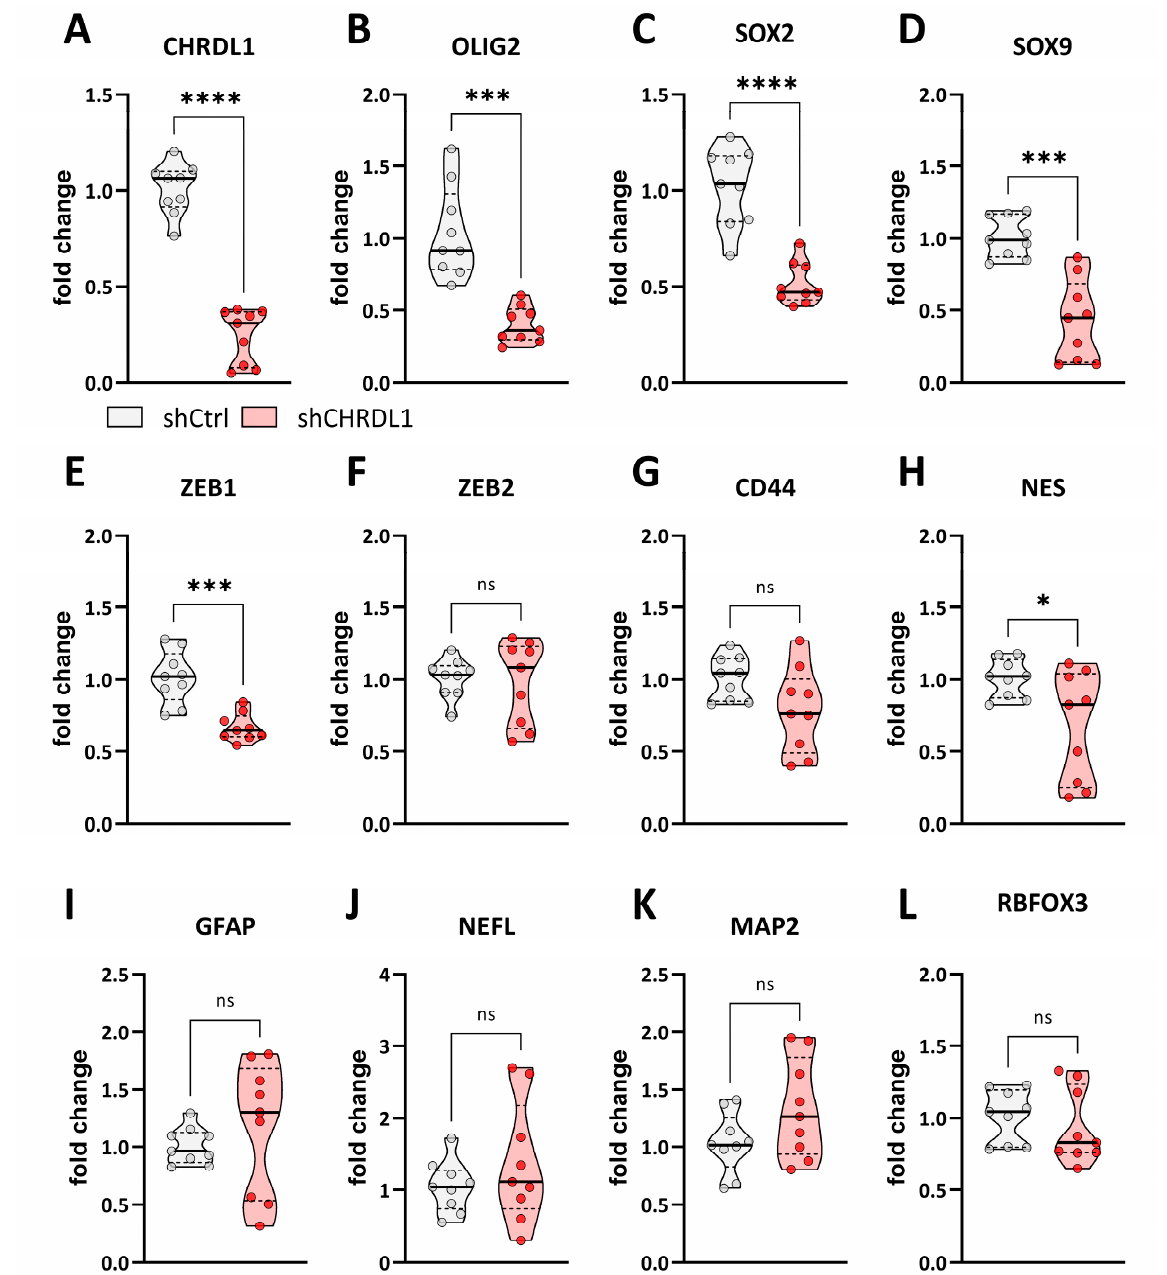
Figure 4. Point-plots of Taqman-based gene expression of GS-5 GSCs after stable transduction with a non-targeting shRNA (shCtrl) or specific shRNA targeting CHRDL1 (shCHRDL1) and measurement of ( A ) CHRDL1 , ( B ) OLIG2 , ( C ) SOX2 , ( D ) SOX9 , ( E ) ZEB1 , ( F ) ZEB2 , ( G ) CD44 , ( H ) NES , ( I ) GFAP , ( J ) NEFL , ( K ) MAP2 and ( L ) RBFOX3 expression. The data are the summary of three experiments performed in triplicates. * p < 0.05; *** p < 0.001; **** p < 0.0001; ns: not significant; unpaired t test with Welch’s correction; white dot: shCtrl, red dot: shCHRDL1.